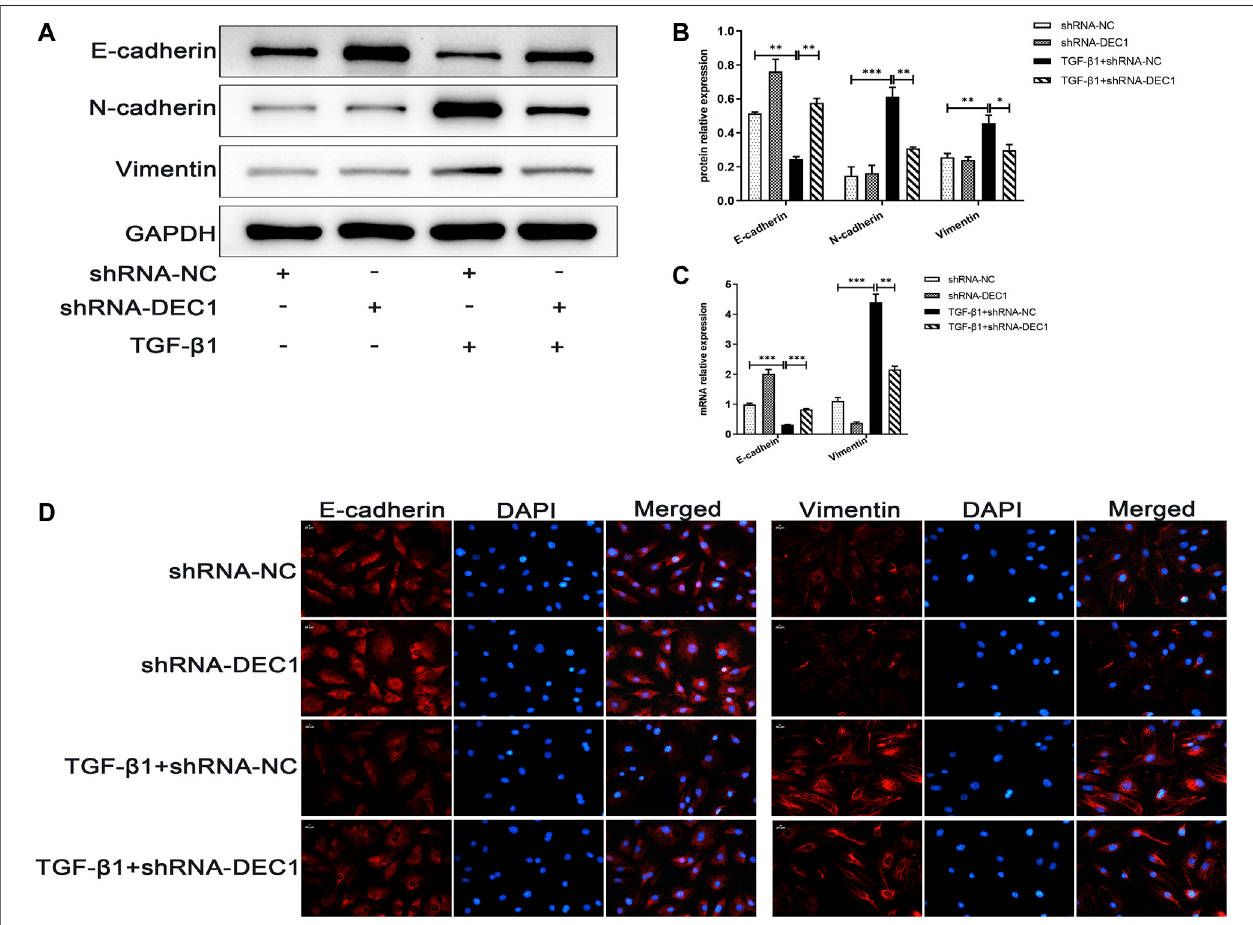
FIGURE8| DEC1 KDsuppresses TGF- β 1-induced EMTinA549cells. shRNA-NC and shRNA- DEC1 A549cells weretreatedwith orwithoutTGF- β 1for 48 h. (A) The protein expression of E-cadherin, N-cadherin and Vimentin in A549 cells were measured by western blotting. (B) Statistical analysis of relative expression levels of proteins in A. (C) The mRNA expression of E-cadherin and Vimentin in A549 cells were assessed by qRT-PCR. (D) Immuno fl uorescent analysis for E-cadherin and VimentinexpressioninA549cells.Scalebar=20 μ m n =3.Dataareshownasthemean±SEM.Statisticalanalysiswasperformedbyone-wayANOVA.* p < 0.05, ** p < 0.01, *** p < 0.001, ns p >